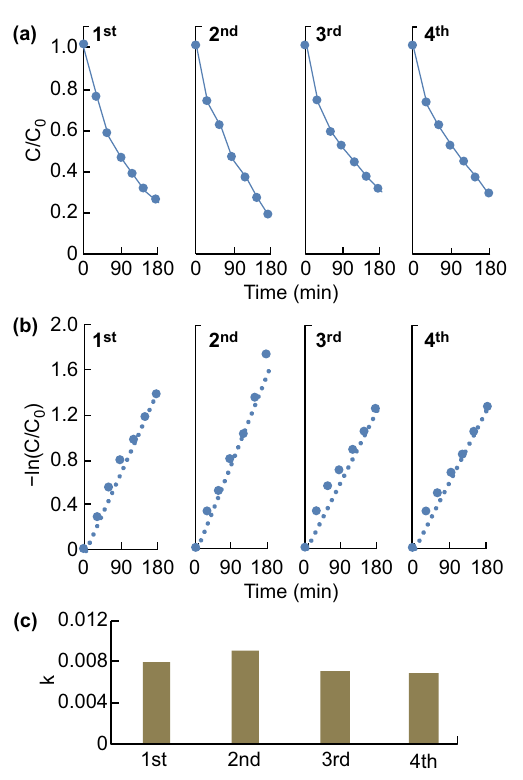
Fig. 6 a Degradation profiles of the MB dye (at 667 nm) in four con- secutive cycles. b Photodegradation kinetics of the MB dye in four consecutive cycles. c Constant